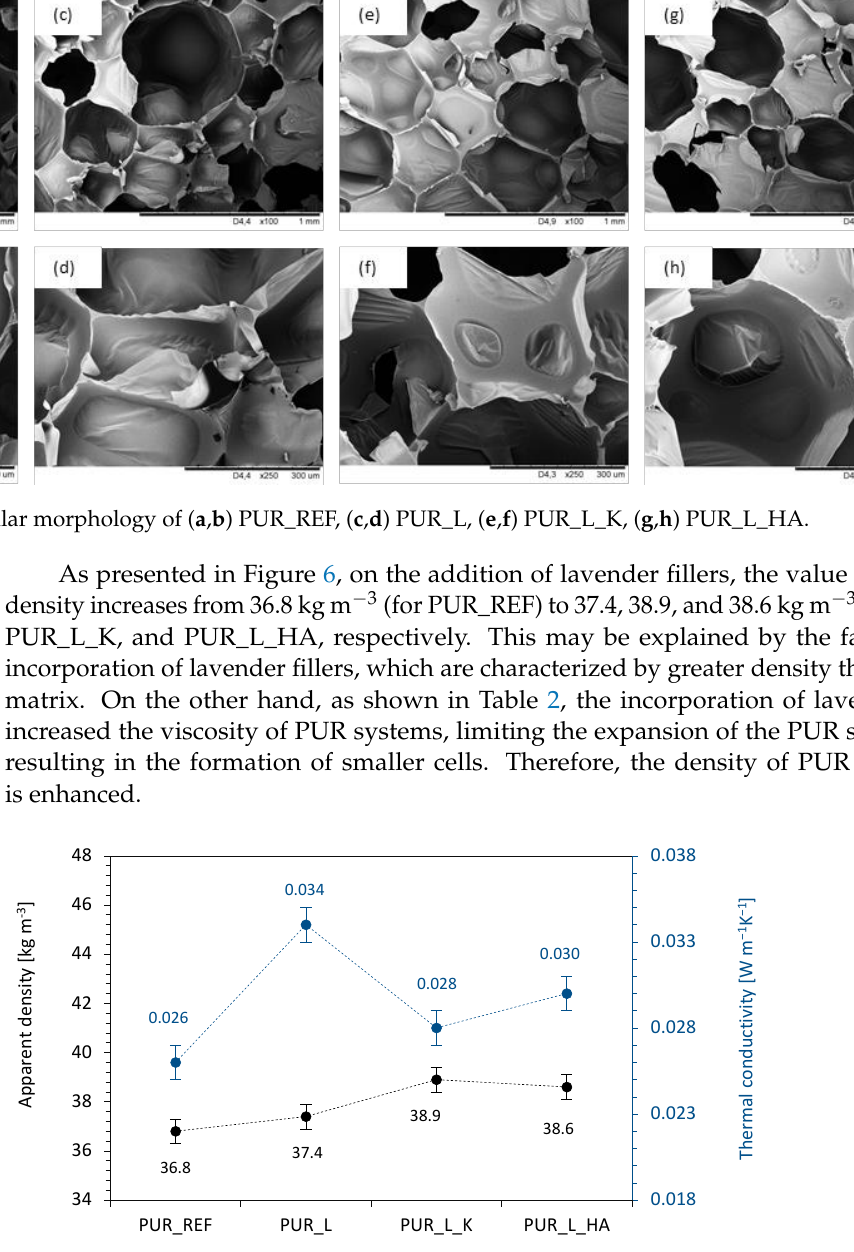
Figure 6. The results of apparent density and thermal conductivity measured for PUR composites. According to the results given in Figure 6, on the incorporation of non-functionalized lavender filler the value of thermal conductivity (λ) increases from 0.026 Wm −1 K −1 (for PUR_REF) to 0.034 Wm −1 K −1 , while after the incorporation of functionalized lavender fillers, the value of λ increases insignificantly to 0.028 and 0.030 Wm −1 K −1 . Such an insignificant increase of λ may be attributed to the incorporation of particles of lavender fillers, which increases the heat transfer through the solid particles. Moreover, the most noticeable increase in λ is observed for PUR composites filled with non-functionalized lavender filler. As discussed previously, comparing to PUR_REF, those samples, are characterized by a higher number of open cells. Due to the diffusion through the PUR structure, the gas inside the PUR cells changes from CO 2 (0.014 Wm −1 K −1 ) to atmospheric air (0.025 Wm −1 K −1 ), increasing the overall value of λ. A similar trend was observed in previous studies as well [56,57]. For example, Paciorek-Sadowska et al. [58] reported that the addition of